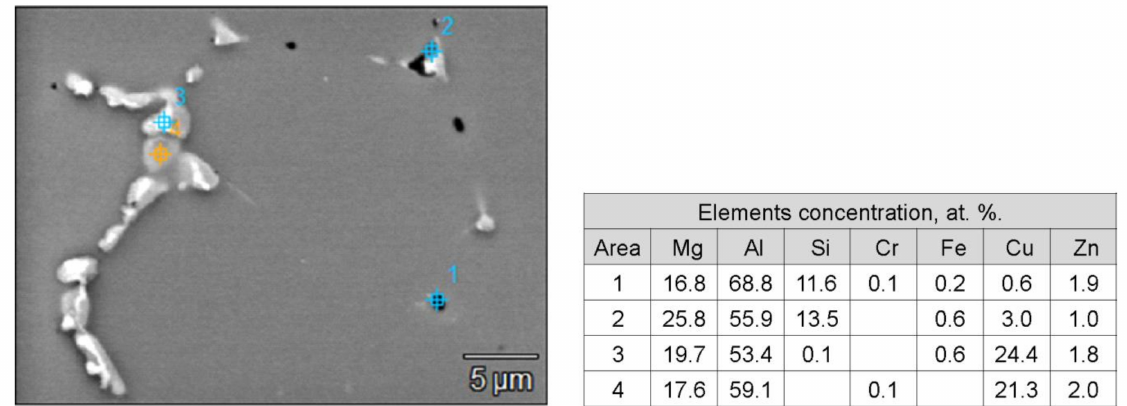
Figure 7. Particles of phase S-Al 2 CuMg and Mg 2 Si, 7075 alloy 2 after soaking at 465 ◦ C for 2 h.